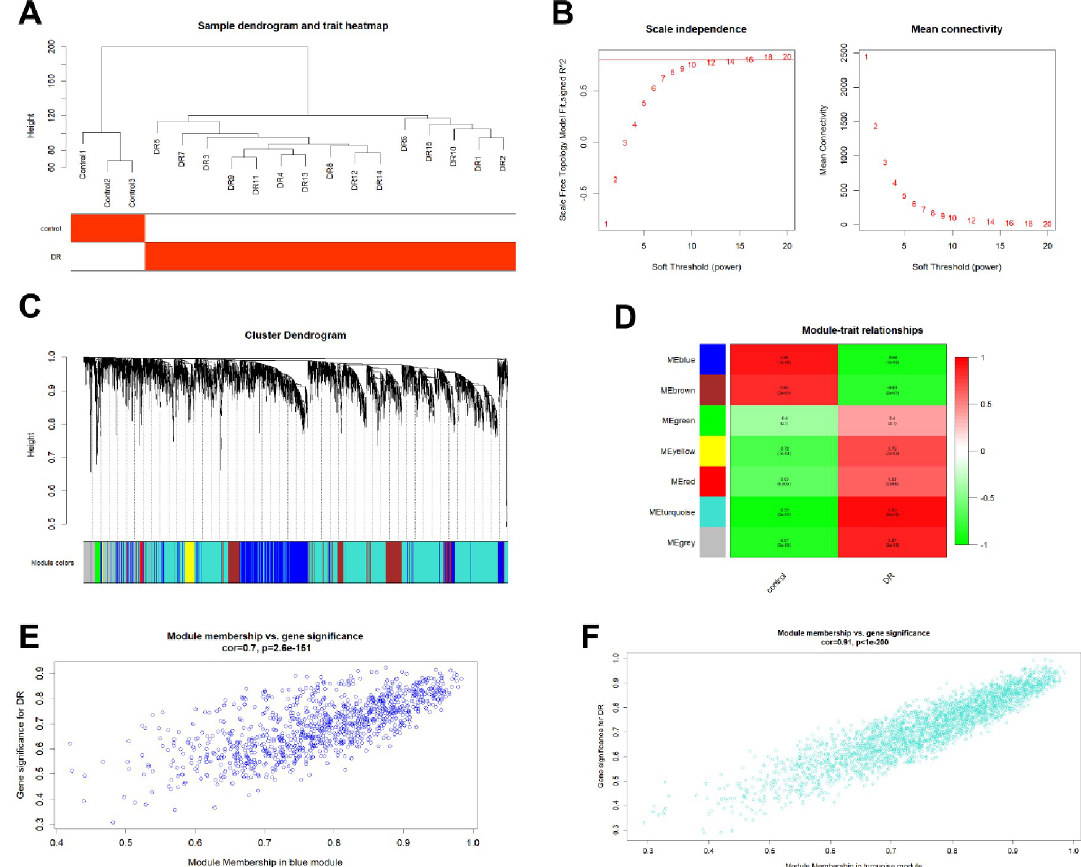
Fig 2. WGCNA of DEGs. (A) Sample clustering tree to check for outliers. (B) Scale-free networks and average connectivity for the soft threshold. (C) Clusters based on the topological overlap matrix. (D) The heat map showed the correlation of module eigengenes with DR patients or controls. (E-F) Scatter plots showing the correlations between MM and GS in the blue and turquoise